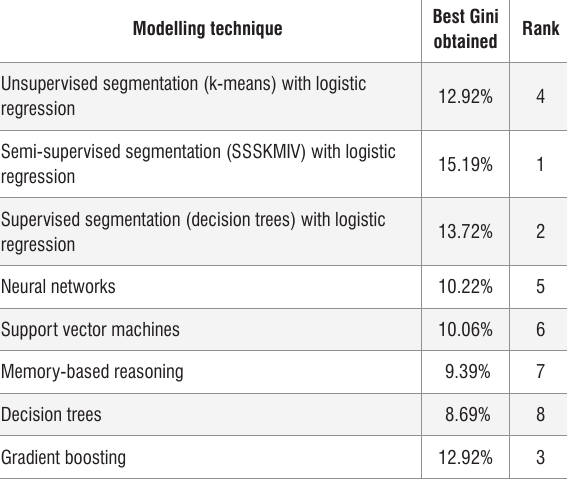
Insurance claim prediction data set: Comparison of performance Modelling technique